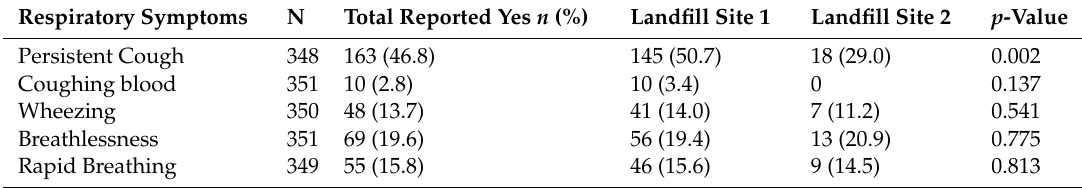
Table 3. Prevalence of self-reported respiratory symptoms stratified by landfill